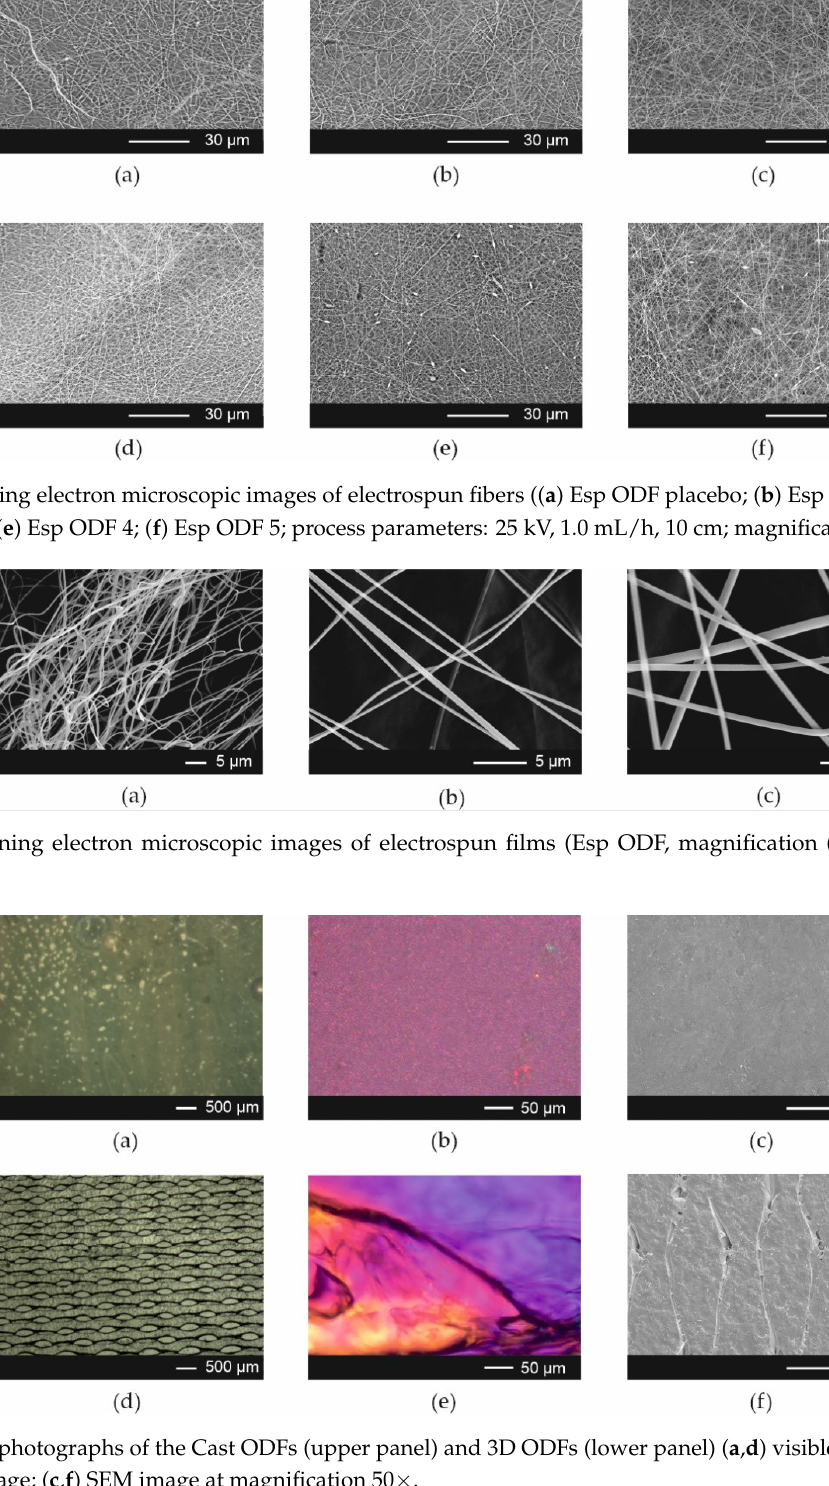
Figure 1. Scanning electron microscopic images of electrospun fibers (( a ) Esp ODF placebo; ( b ) Esp ODF 1; ( c ) Esp ODF 2; ( d ) Esp ODF 3; ( e ) Esp ODF 4; ( f ) Esp ODF 5; process parameters: 25 kV, 1.0 mL/h, 10 cm; magnification 2000×).